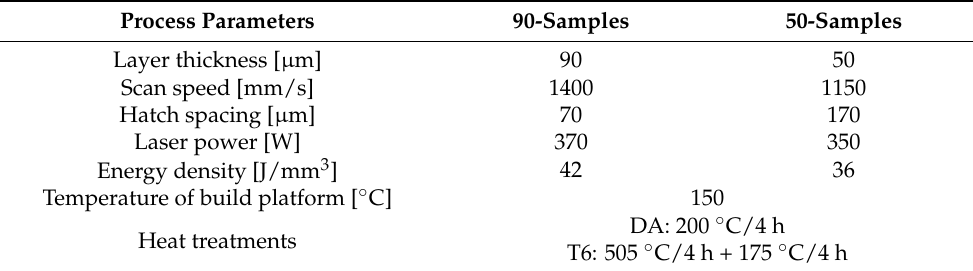
Figure 1. ( a ) Job of SL (yellow region) and DL (red region) AlSi10Mg 90-samples; ( b ) Optical microscope micrograph which shows the bar cross-section ( (cid:74) Build direction). Table 2. Process parameters used for 50 and 90 AlSi10Mg